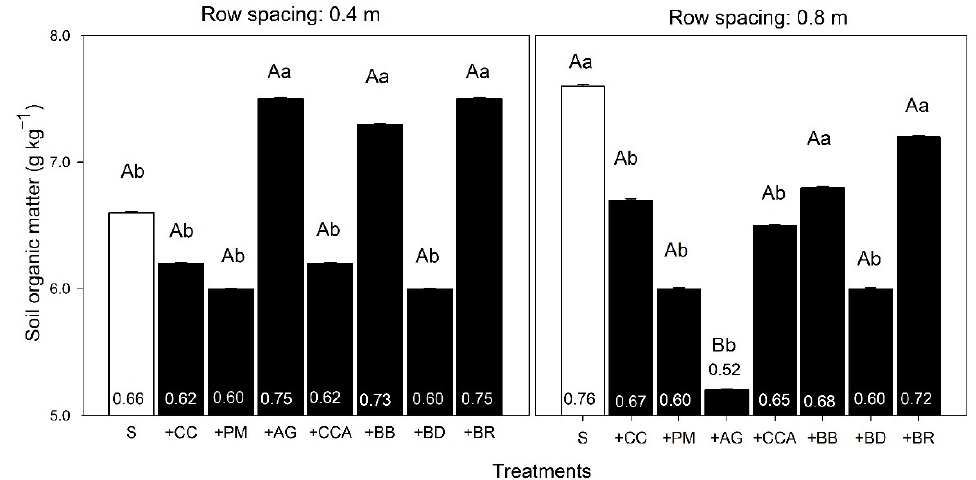
Figure 3. Soil organic matter (g kg − 1 ) in systems of production with sorghum and grasses ( Andropogon gayanus —AG; Cenchrus ciliaris cv. Aridus—CCA; Cenchrus ciliaris cv. 131—CC; Brachiaria decumbens —BD; Brachiaria brizantha —BB; Brachiaria ruziziensis —BR; Panicum maximum —PM) in row spacings of 0.4 and 0.8 m in different soil layers (0.0–0.2 m). The same lowercase (intercropping) and uppercase letters (row spacing) belong to the same grouping, according to the Scott-Knott test (1% probability). Averages are represented with an equivalent standard deviation of the population.